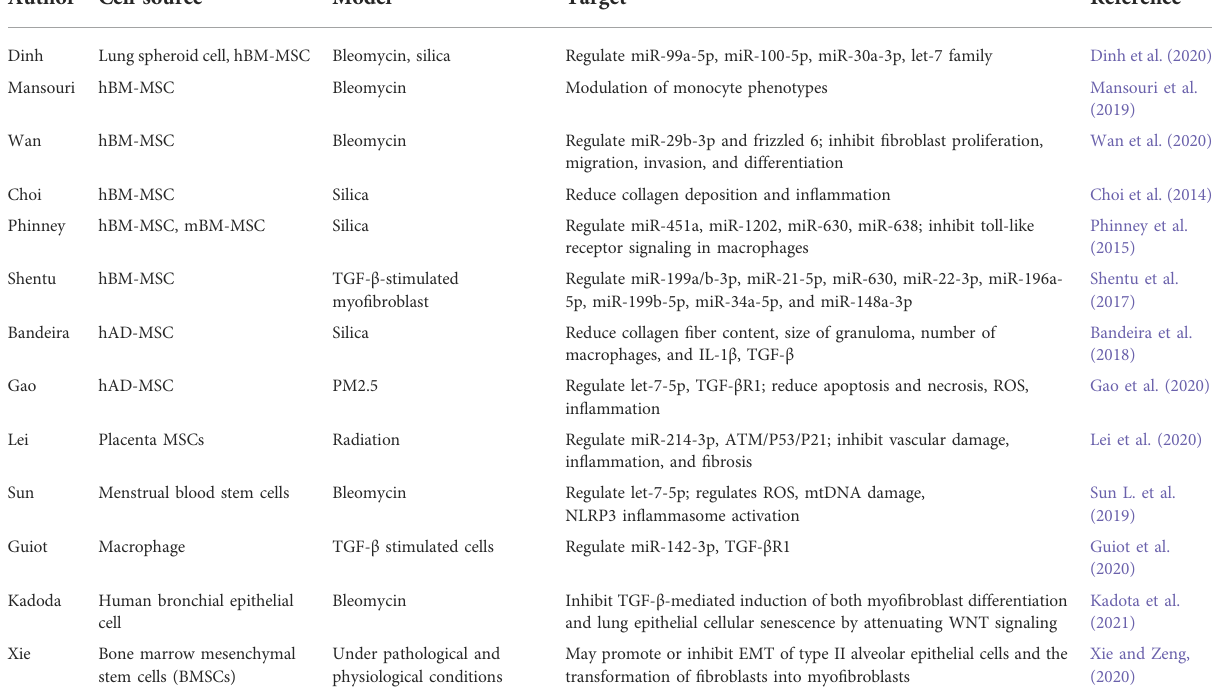
TABLE 2 Application of exosomes in experimental models of pulmonary fi brosis.